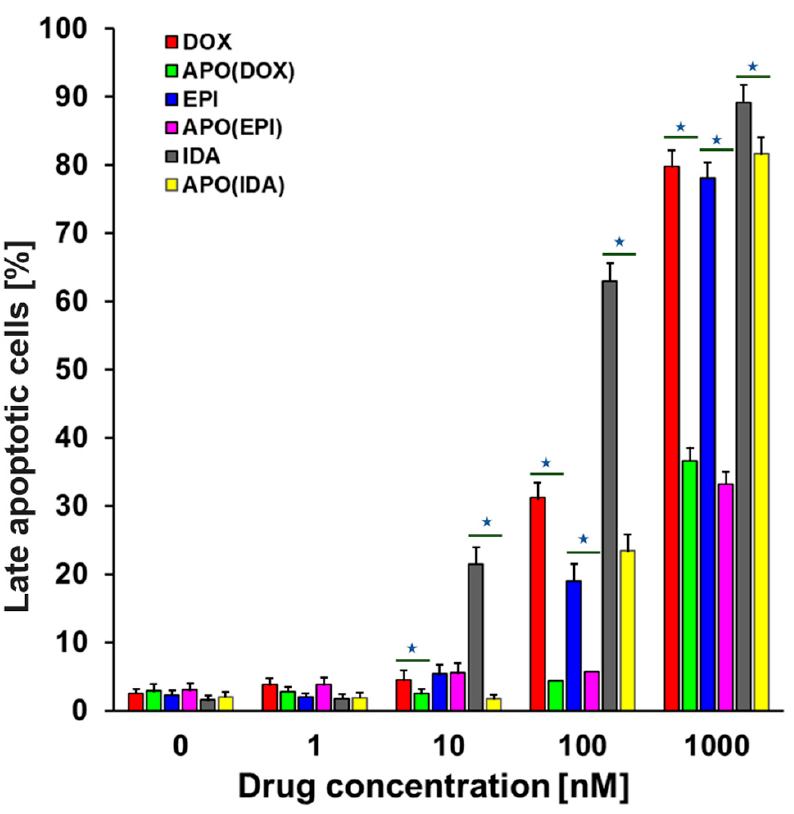
Figure 5. Dependence of the fraction of late apoptotic cells, found after 72 h treatment of MDA-MB-231 breast cancer cells with ANTR drugs, on concentration of drugs, injected as free drugs or in form of APO(drug) nanocages. All data are expressed as mean ± SD ( n = 5); statistically significant ( P < 0.05) difference is shown as “*”.